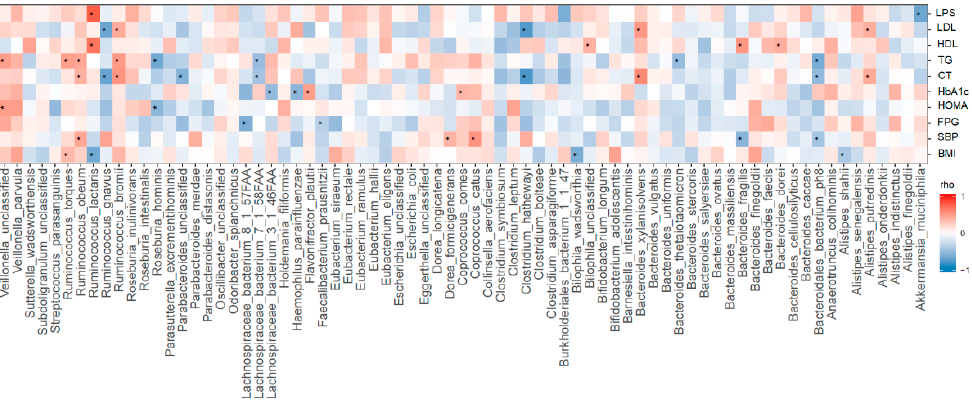
Figure 3. Spearman correlation analysis between species abundance and clinical outcomes (* p < 0.05).